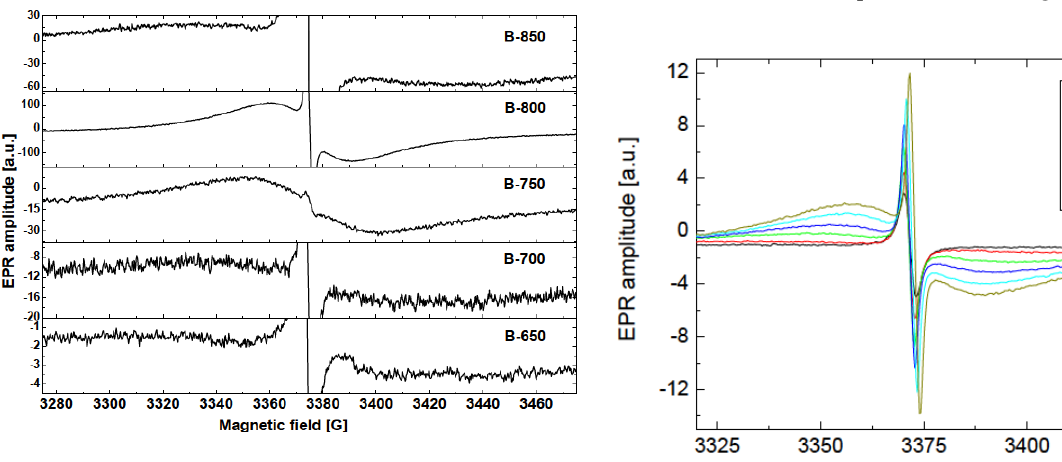
Figure 12: EPR spectra of the BHT component (broad line) in five samples registered at RT. The vertical scale unit is different for different samples, the EPR amplitude is rescaled for sample unit mass. The central narrow line is the N component.